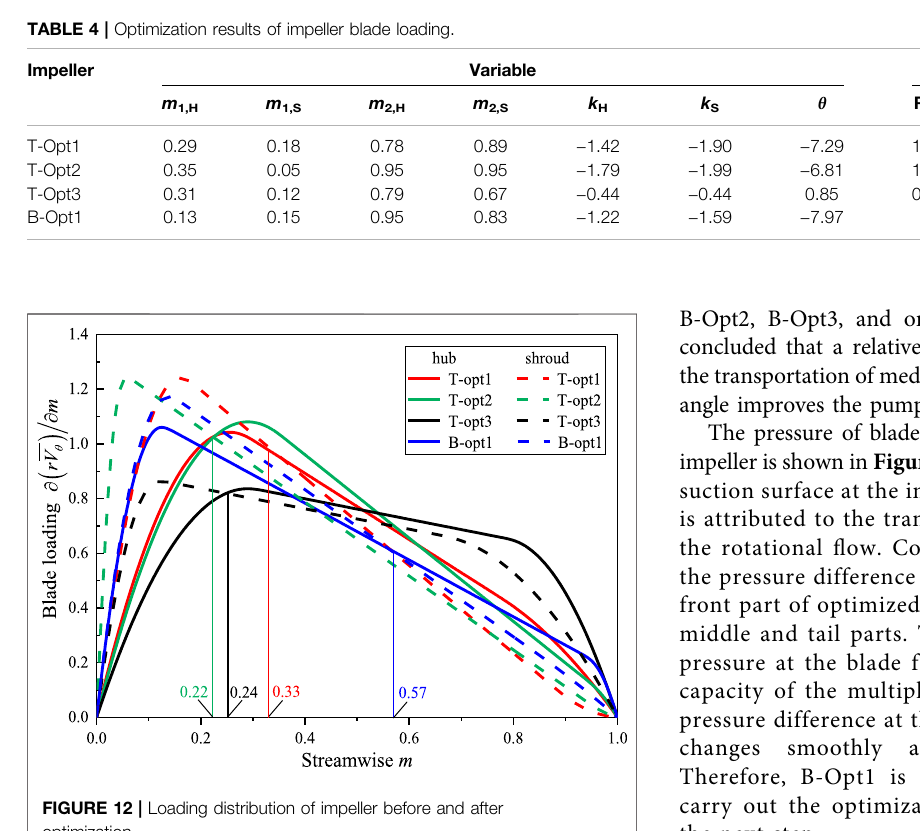
Frontiers in Energy Research |